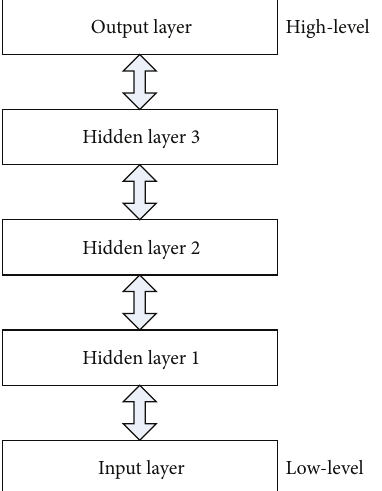
Figure 4: Hierarchical architecture of DLN.